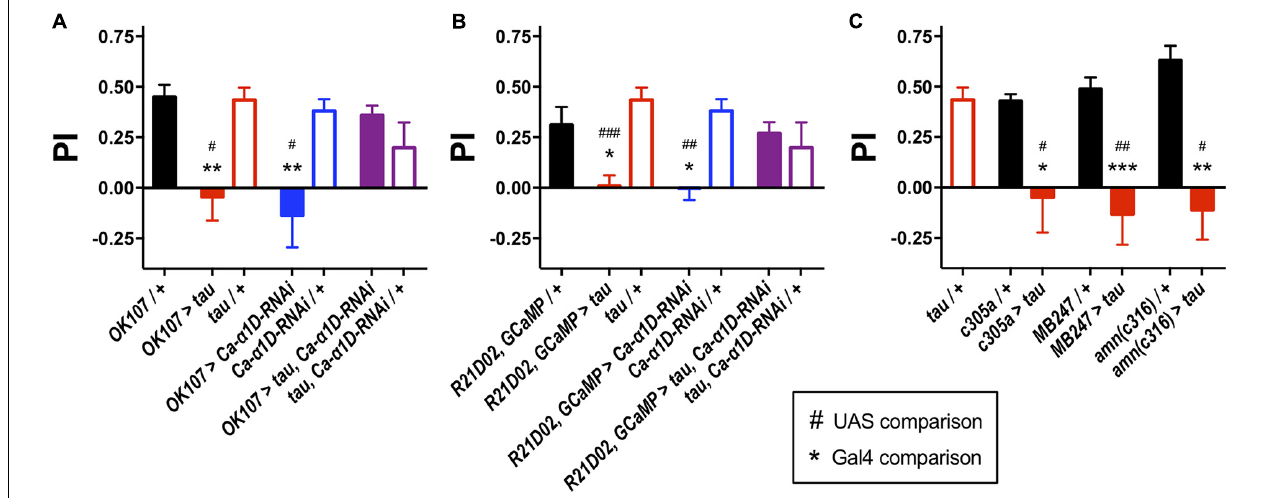
FIGURE 1 | Knock-down of L-type Ca 2 + channels rescued tau-induced memory defects. (A) Tau expression in the MB ( OK107-Gal4 ) ablated one-hour memory ( n = 7 experiments with 50–100 flies each, red bar), as did the expression of an RNAi to the gene encoding the L-type Ca 2 + channel alpha subunit ( Ca- α 1D-RNAi , n = 8, blue bar) compared to both Gal4 ( n = 12, black bar) and UAS controls (tau, n = 11, open red bars; Ca- α 1D-RNAi , n = 9, open blue bars). Co-expression of both transgenes ( n = 12, purple bar) resulted in flies with a memory performance equivalent to that of control animals, as did the UAS controls ( n = 4, open purple bar). (B) Likewise, expression of tau ( n = 9) or Ca- α 1D-RNAi ( n = 6) in the MB efferent M4/6 neurons ( R21D02-Gal4 , n = 10) abolished memory. Memory was restored to wild-type levels by co-expression of both transgenes ( n = 15). (C) Expression of tau in neuronal subpopulations of the MB impaired memory.